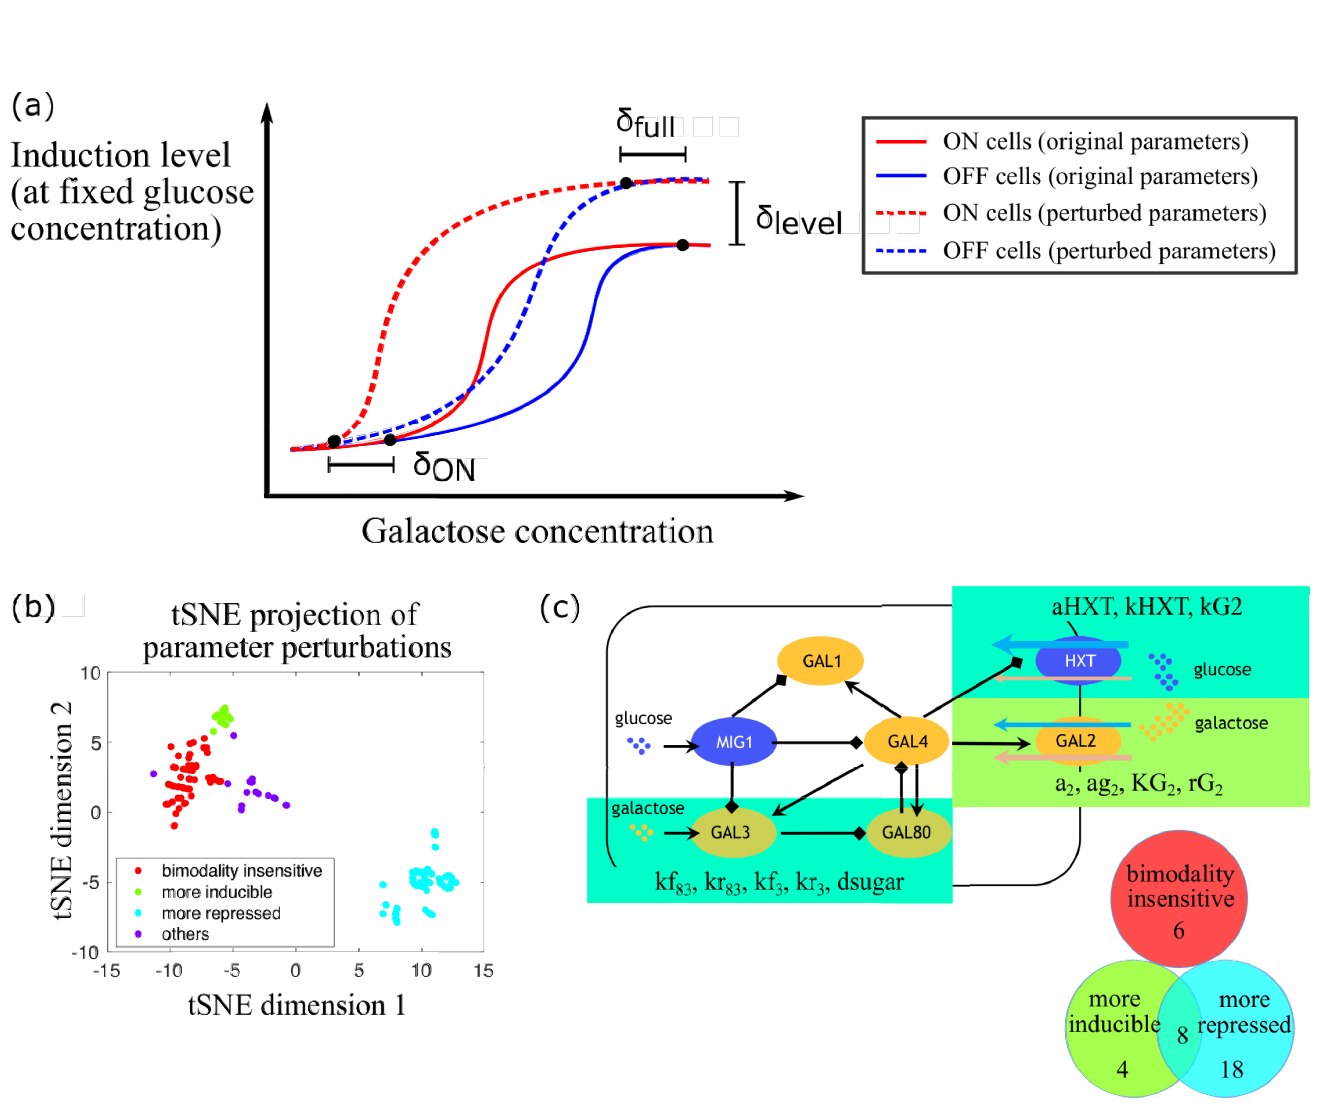
Fig 3. In silico survey of parameters that can affect bimodal range. (a) Illustration of the induction metrics we inspected. Bimodal range is affected by inherent difference between yeast strains which we modeled by perturbing parameter values, and such yeast cells exhibited bimodality at lower galactose concentrations. The difference in the galactose concentrations where bimodality emerged is represented by δ ON . Similarly, the difference in the galactose concentrations where bimodality vanished is represented by δ full . δ level represents the difference in the steady state induction levels. (b) t-distributed stochastic neighbor embedding (t-SNE) visualization of parameter perturbation clusters identified according to their effect on bimodal range variation. Minkowski distance metric was used, loss = 0.080. (c) When increasing and decreasing parameter values, 8 parameters made the pathway both more inducible and more repressed, and 4 parameters related to Gal2p made the pathway more inducible, these parameters with their associated biological implications are highlighted in color boxes. Moreover, 18 parameters made the pathway more repressed, and 6 parameters showed minor effect on bimodal range.